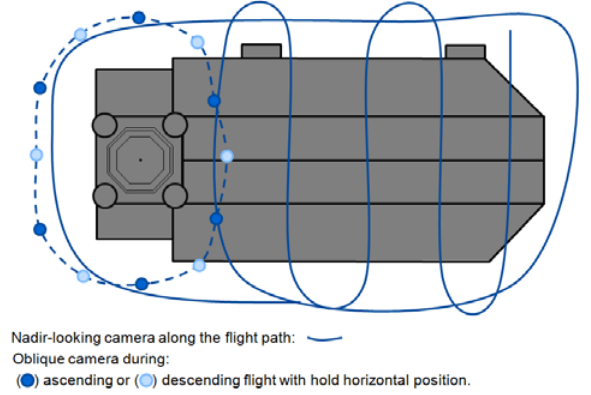
Figure 5. Flight plan of the church and the tower of